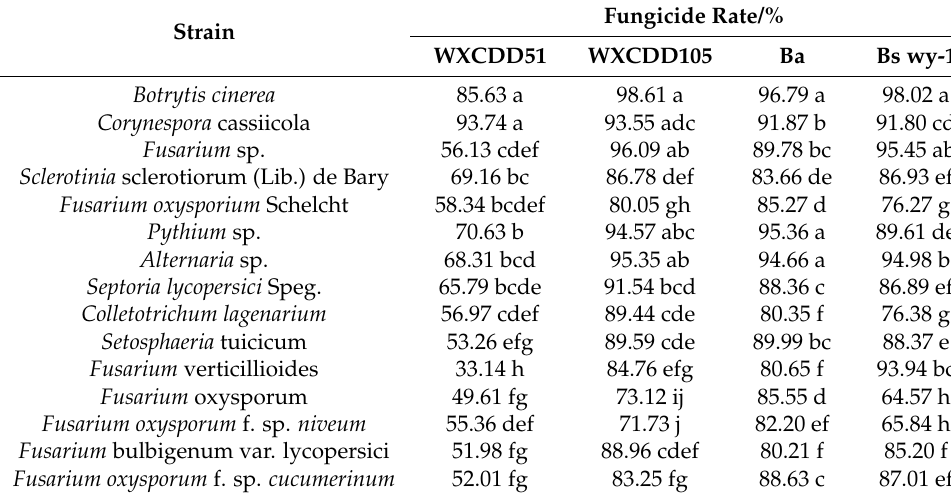
Note: Small letters behind the data of the same column indicate significant difference at the 0.05 level. The same as below. Different letters indicate significant differences within each category according to one-way analysis of variance (ANOVA) followed by Duncan’s test at the 0.05 alpha level of confidence.